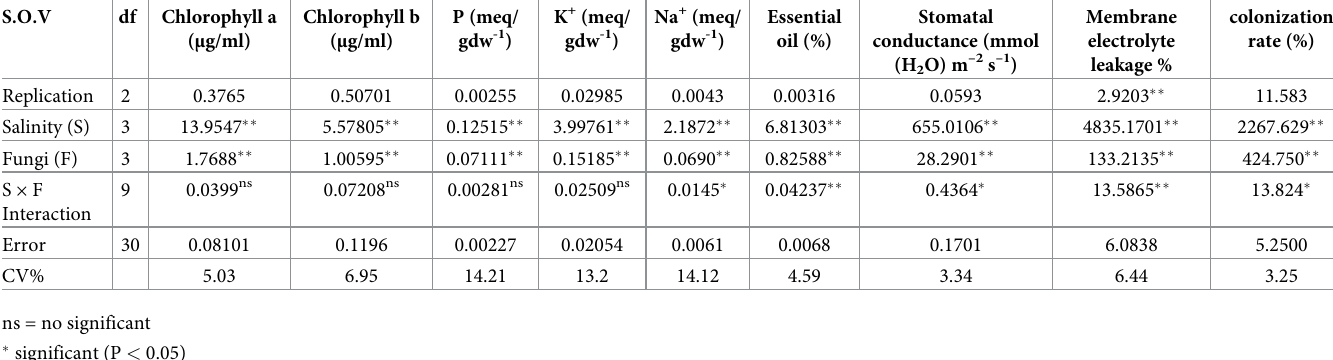
Table 3. Variance analysis of salinity and P . indica and AMF effects on measured physiological and biochemical parameters of peppermint. S.O.V df Chlorophyll a ( μ